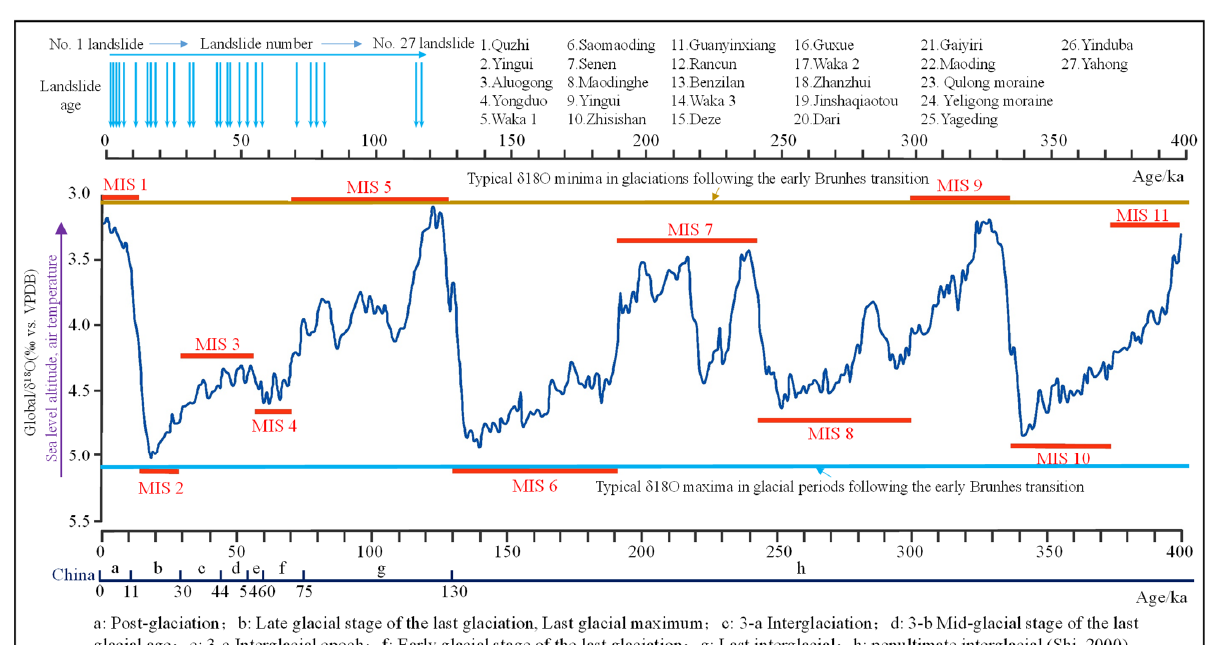
Figure 11. The age of the landslide in the study area corresponds to the global glacial age and the Chinese glacial age.